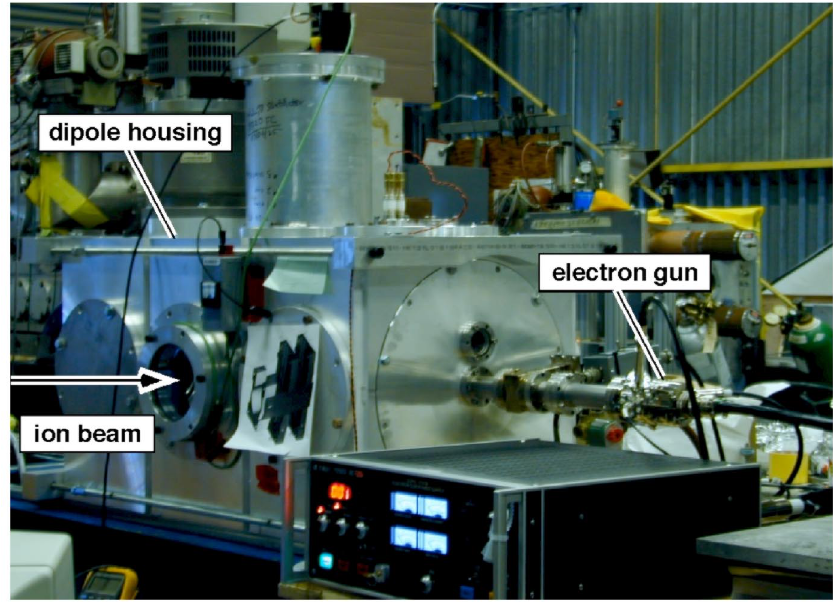
FIG. 9. (Color) Photograph of the NTX nonintercepting beam diagnostic.